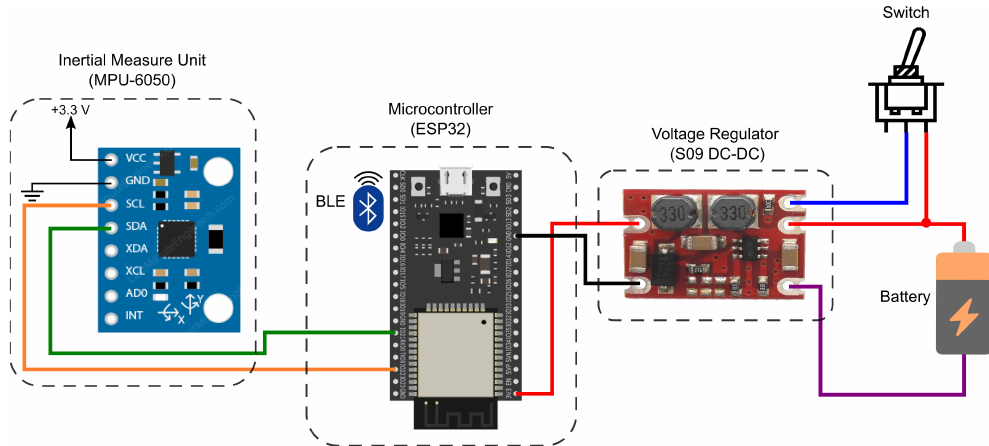
Figure 1. IMU acquisition system diagram.